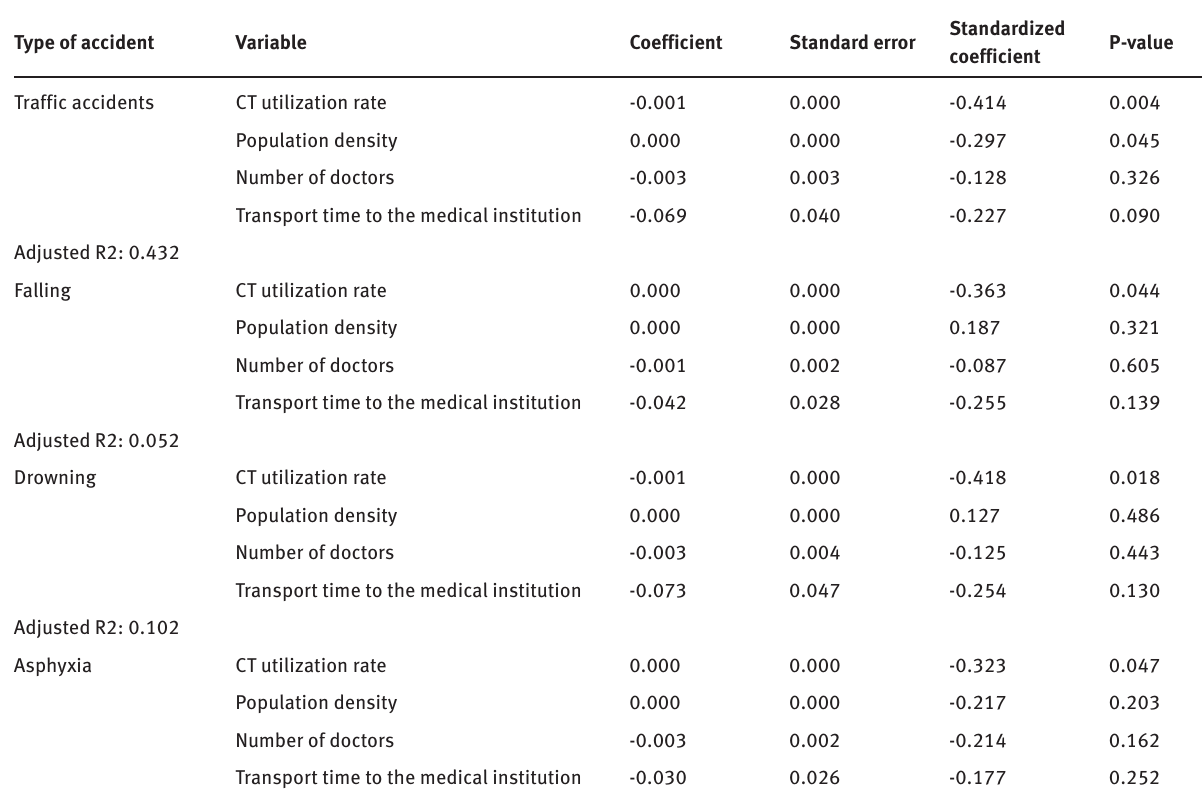
Table 5: Results of multiple regression analysis for accidents by each